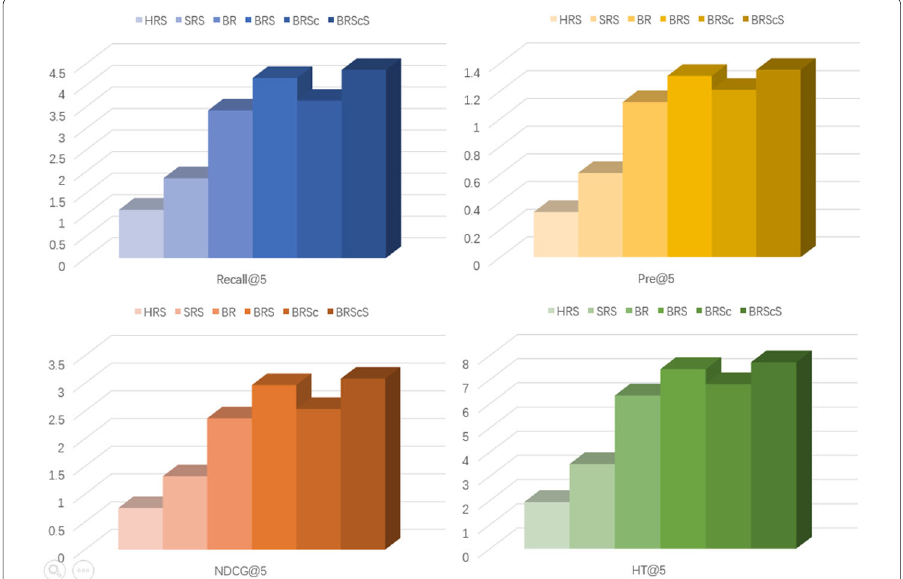
Fig. 5 Indicators of top-5